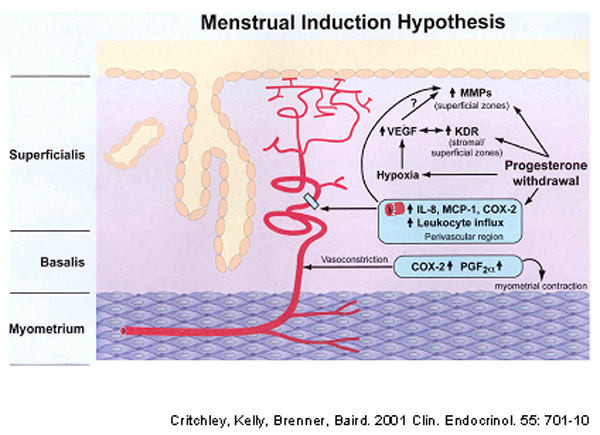
Coincident events of progesterone withdrawal and hypoxia. Progesterone withdrawal results in an up-regulation of inflammatory mediators, production of MMPs, a leukocyte influx and expression of stromal KDR in the upper endometrial zones. There is coincident hypoxia and an up-regulation of VEGF. VEGF binds to its type 2 receptor, KDR and there is a paracrine/autocrine action on the up-regulation of MMP production in the same endometrial upper zone stromal cells. Menstrual sloughing takes place from the superficial regions of the endometrium. Reproduced with permission.